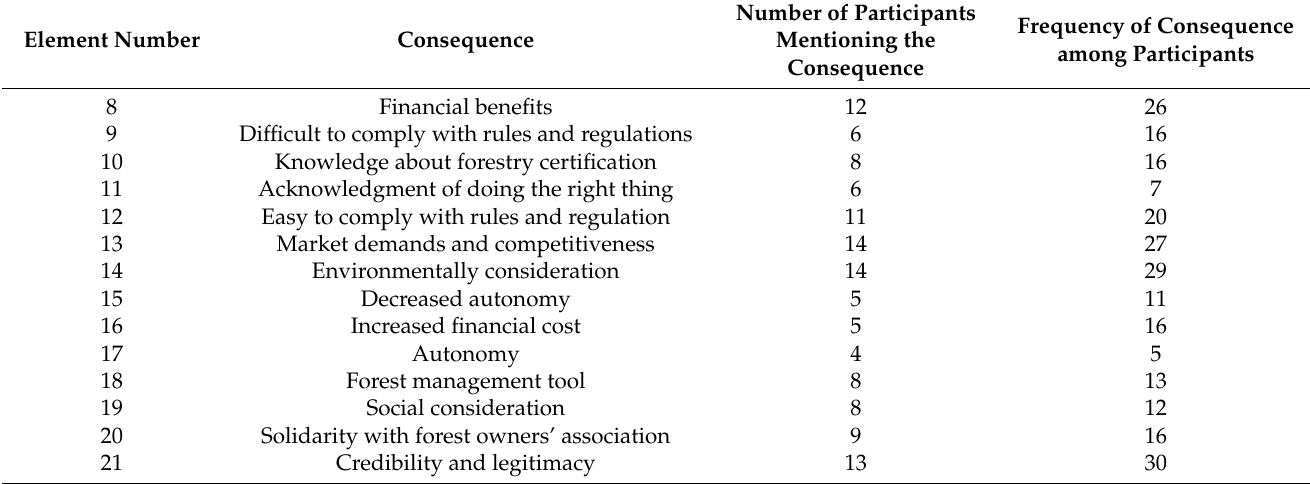
Table 5. Frequency of consequences mentioned in interviews by participants.